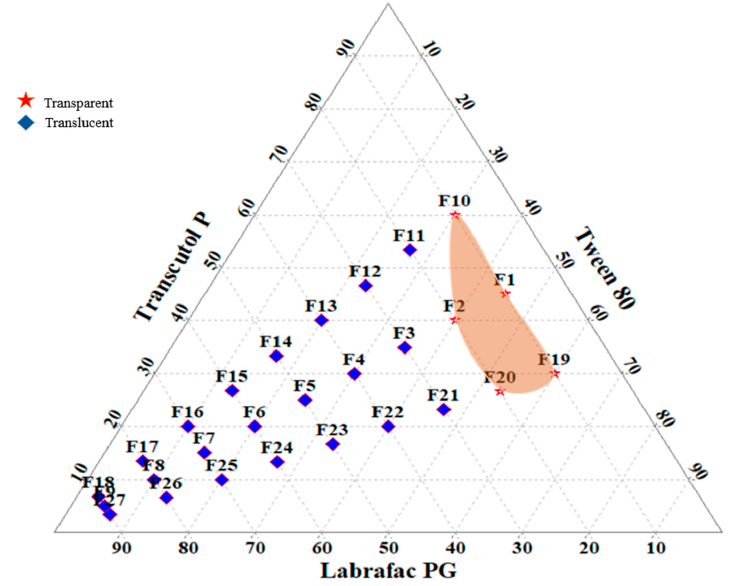
Figure 1. Ternary phase diagram of various L-SNEEDS prototypes .